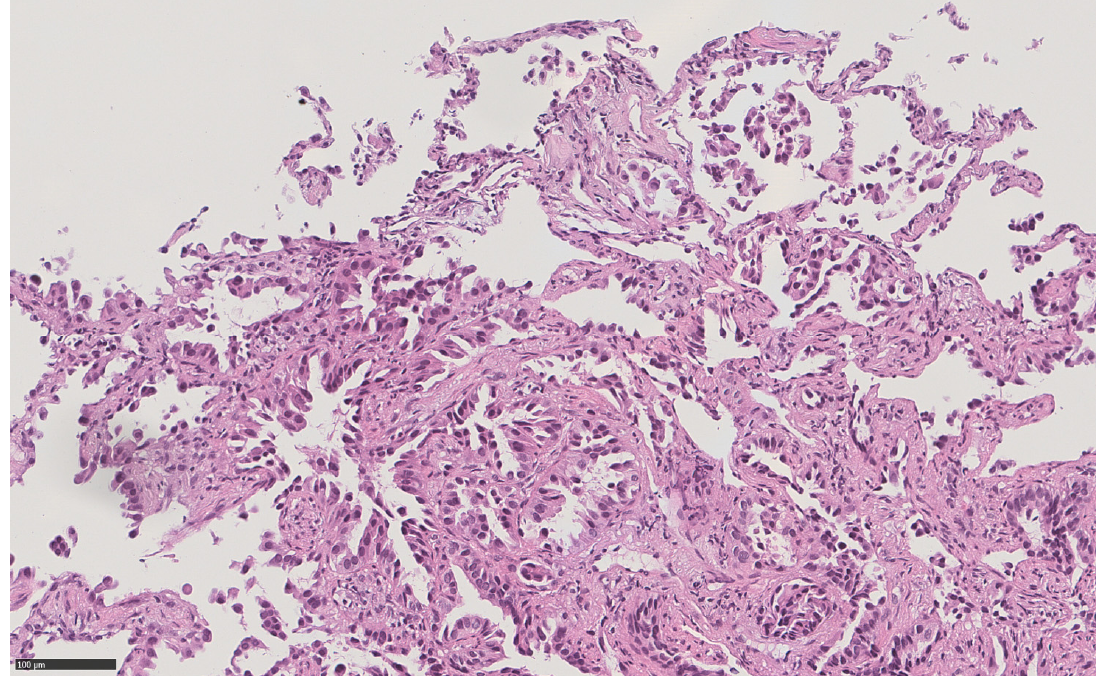
Figure 2. High power (21x) hematoxylin and eosin view of a bronchoscopic transbronchial pulmonary sample in the same patient, showing primary lung adenocarcinoma with lepidic non mucinous and acinar patterns.